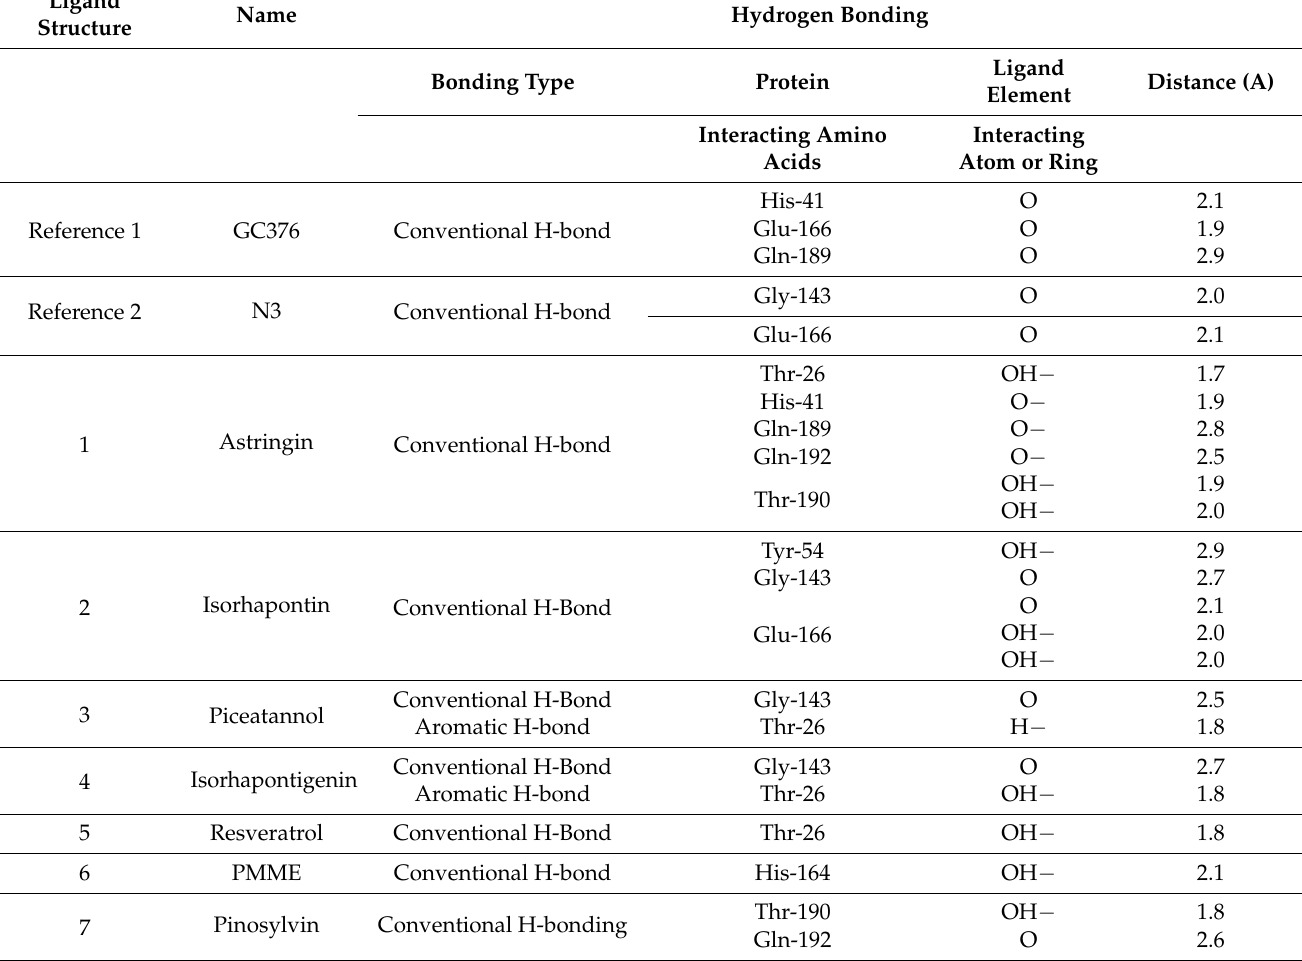
Table 4. Distance parameters of hydrogen bonds derived from molecular docking of reference and stilbene ligands with M pro